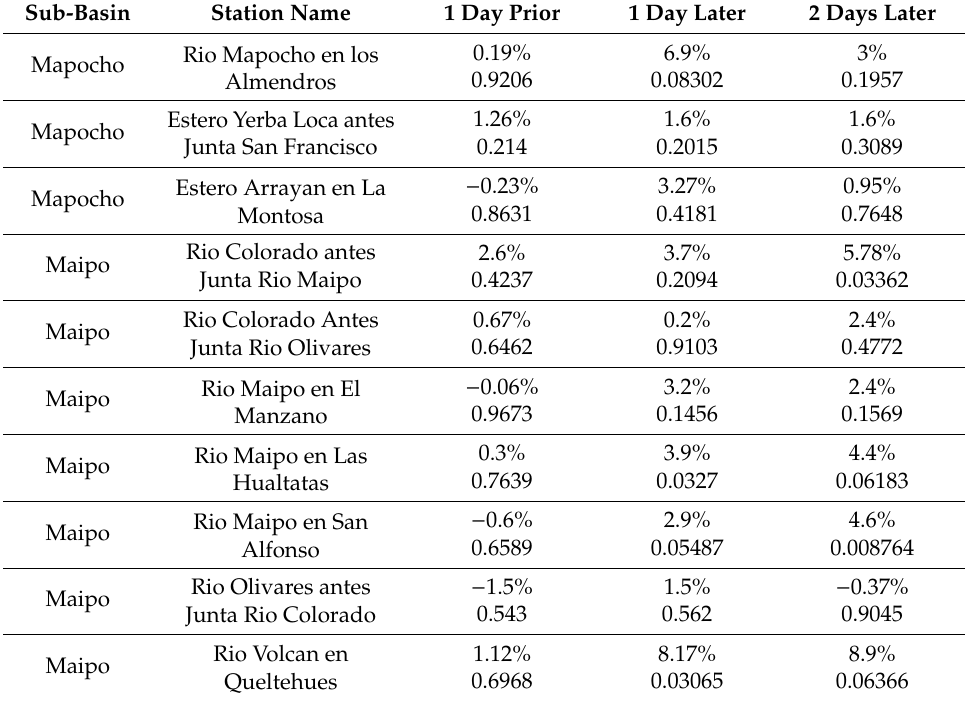
Table 3. Test of 4-day interval changes in river-flow for likely rain-on-snow events